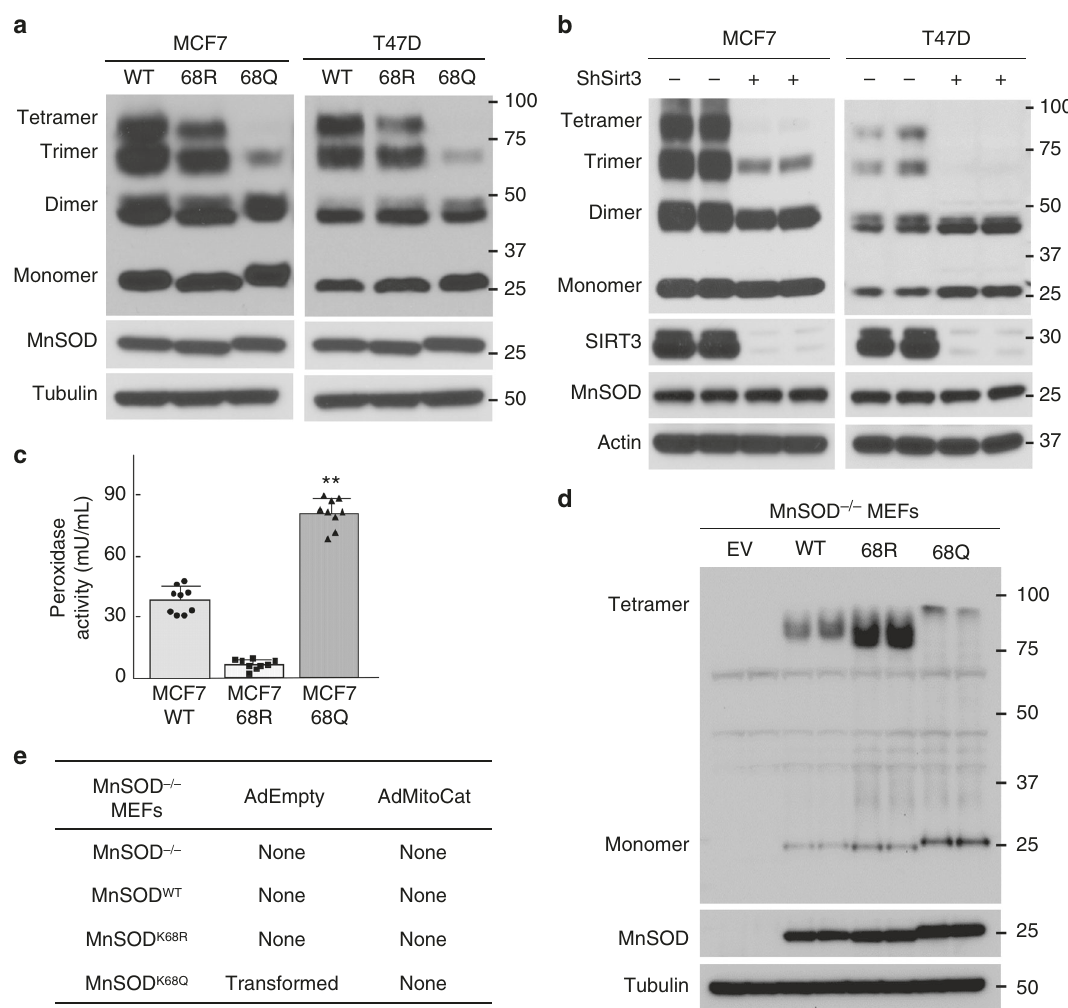
Fig. 3 MnSOD-K68Q alters MnSOD conformation and exhibits peroxidase activity. a MCF7 (left panel) and T47D (right panel) cells expressing MnSOD WT , MnSOD K68R , or MnSOD K68Q were analyzed by semi-native crosslinking and blotting with an anti-MnSOD antibody. b MCF7 (left) and T47D (right) cells expressing shSIRT3 were analyzed by crosslinking. c Flag-MnSOD WT , Flag-MnSOD K68R , and Flag-MnSOD K68Q expressed in MCF7 cells were measured for peroxidase activity. Error bars represent ± 1 SEM. ** p < 0.01. d Immortalized MnSOD − / − pMEFs expressing MnSOD WT , MnSOD K68R , or MnSOD K68Q were analyzed by semi-native crosslinking and immunoblotted with an anti-MnSOD antibody. e MnSOD − / − pMEFs expressing MnSOD WT , MnSOD K68R , or MnSOD K68Q , without or with Ad-Mito-Cat or Ad-Empty, were measured for transformation. All experiments were done in triplicate. A one-way